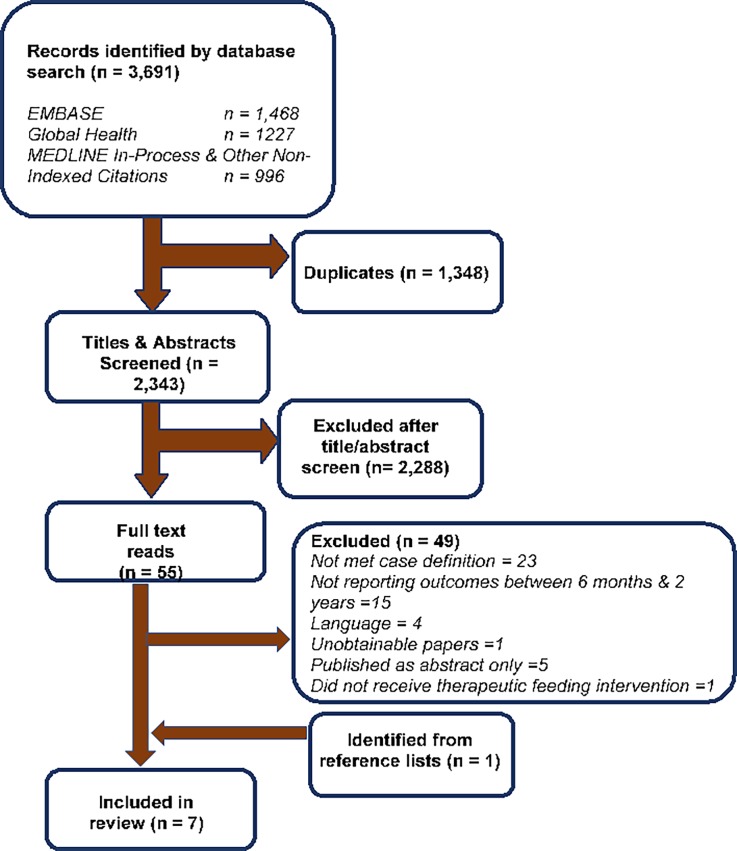
PRIMSA flow diagram.